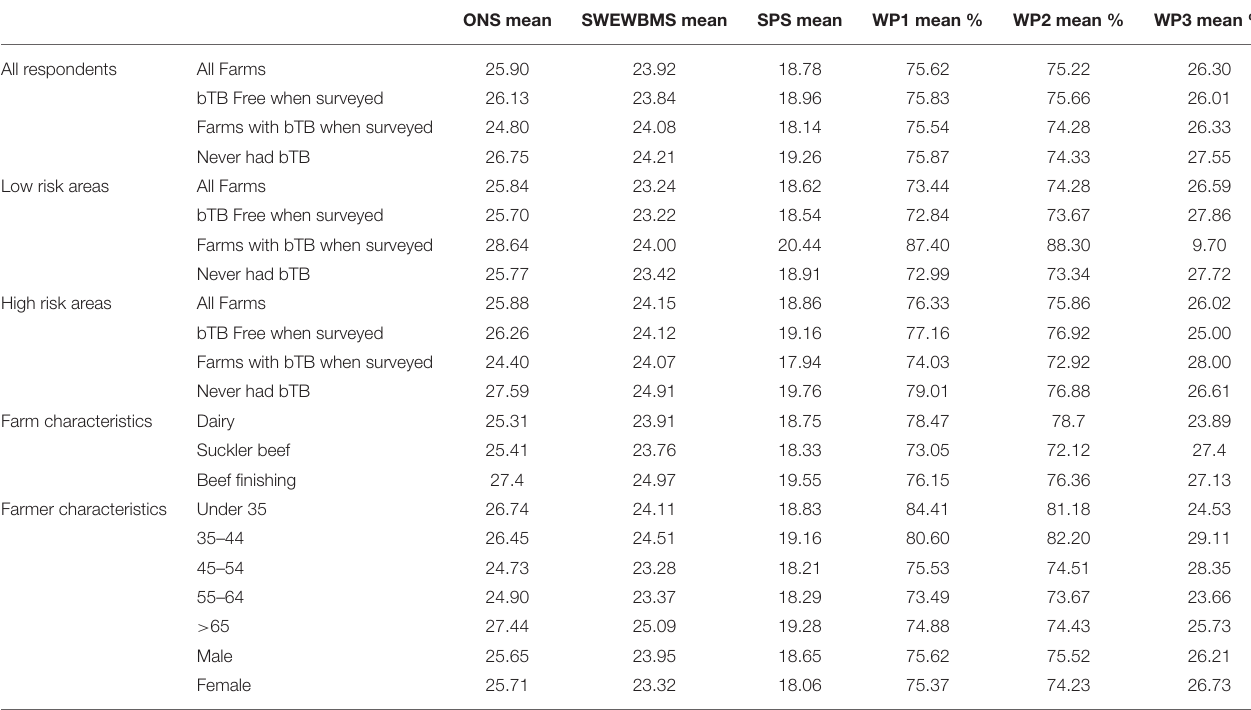
TABLE 7 | Mean SWB ratings and farm